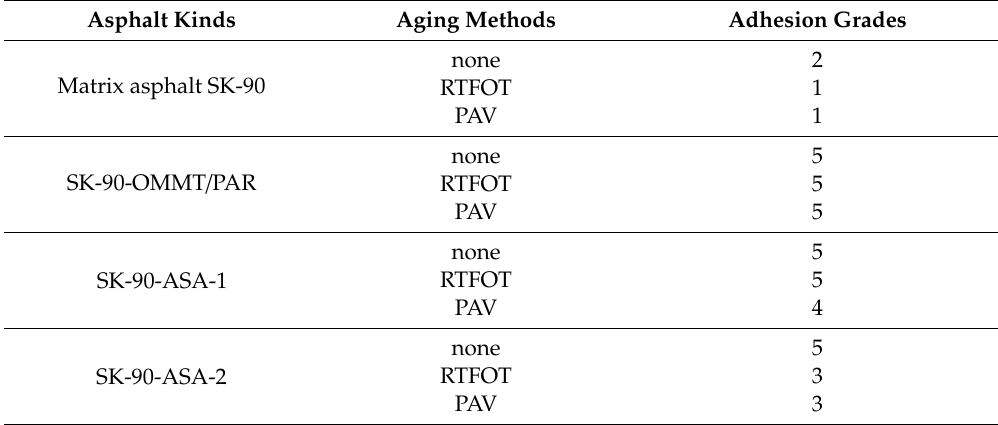
Table 9. Adhesion grades of SK-90 asphalt modified by anti-stripping composites and granite. Asphalt